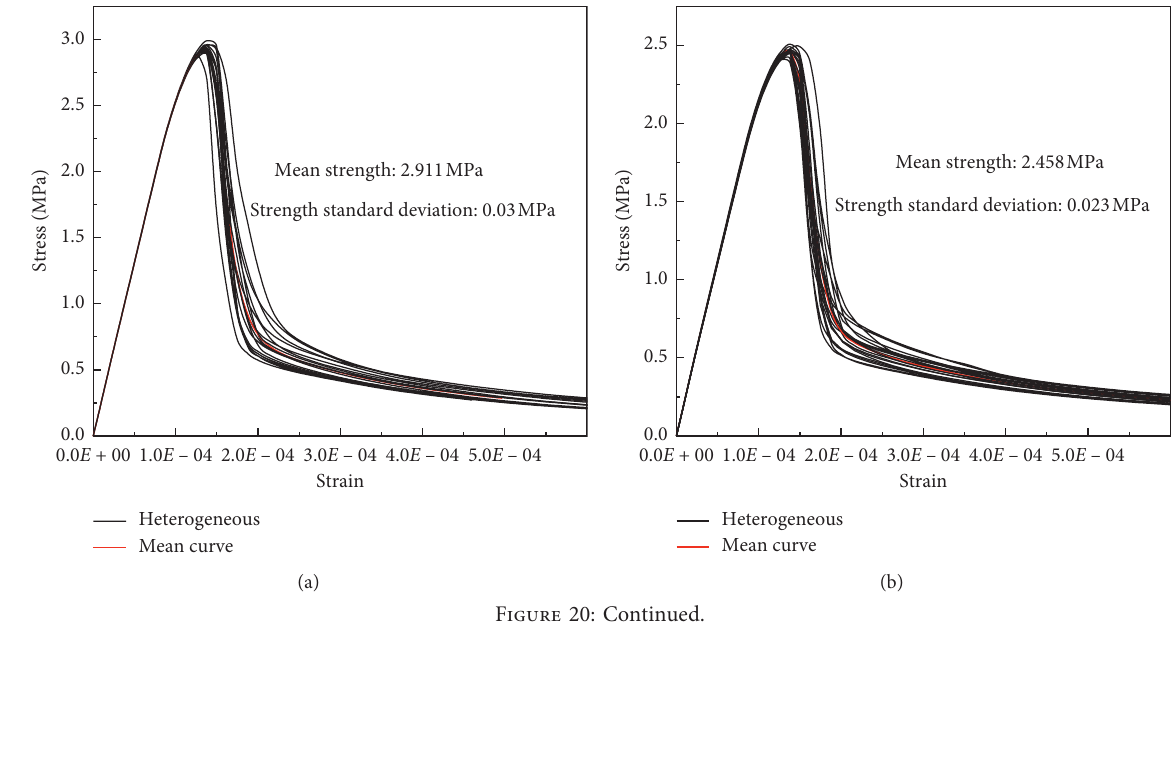
Figure 19: Compositions of the mesoscale model with rubber particle replacing coarse aggregate and sand. (a) Rubber particle replacing the aggregate model. (b) Rubber particle replacing the sand model.